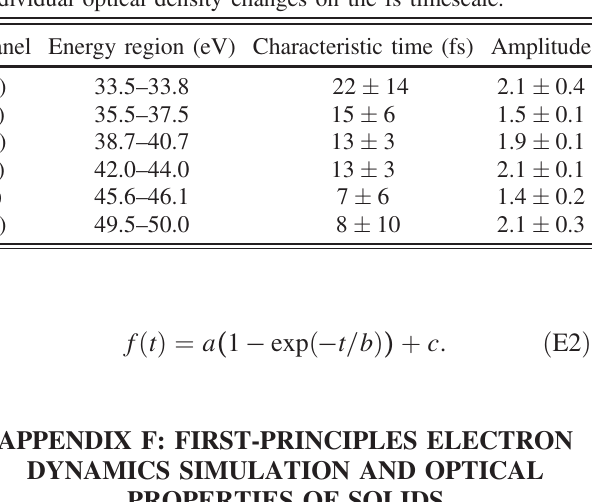
TABLE I. Fitting values of the sigmoid function to the individual optical density changes on the fs timescale.